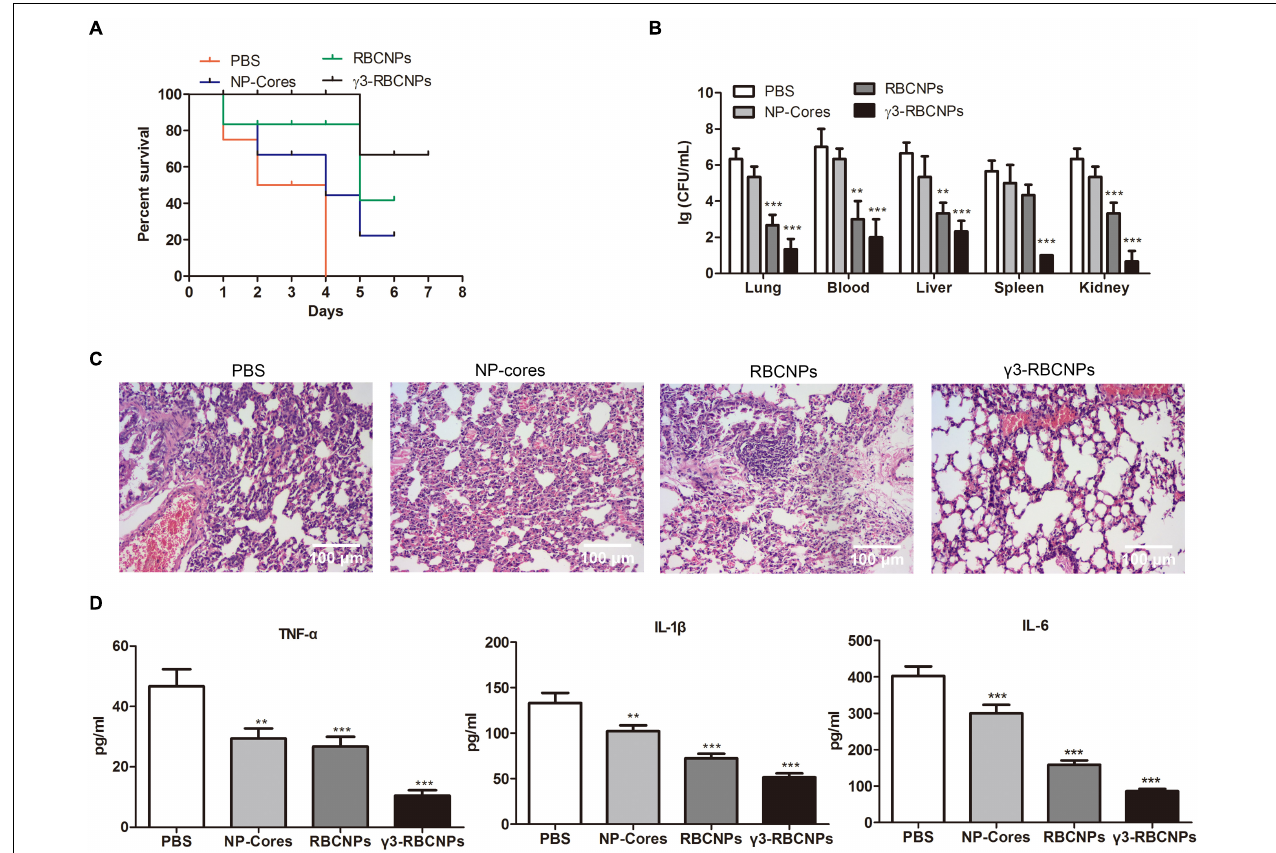
FIGURE 7 | Evaluation of the therapeutic effect of γ 3-RBCNPs in vivo . (A) Survival curves of mice with an acute lung infection in each group after being treated with NP-cores, RBCNPs, and γ 3-RBCNPs. (B) Quantification of bacterial counts in main tissues of mice after treatment. (C) HE staining was performed to evaluate the degree of lung infection in mice after treatment. Scale bar = 100 µ m. (D) ELISA assay was conducted to detect the level of TNF- α , IL-1 β , and IL-6 in the serum of mice. ** P < 0.01 vs. PBS group, *** P < 0.001 vs. PBS group.